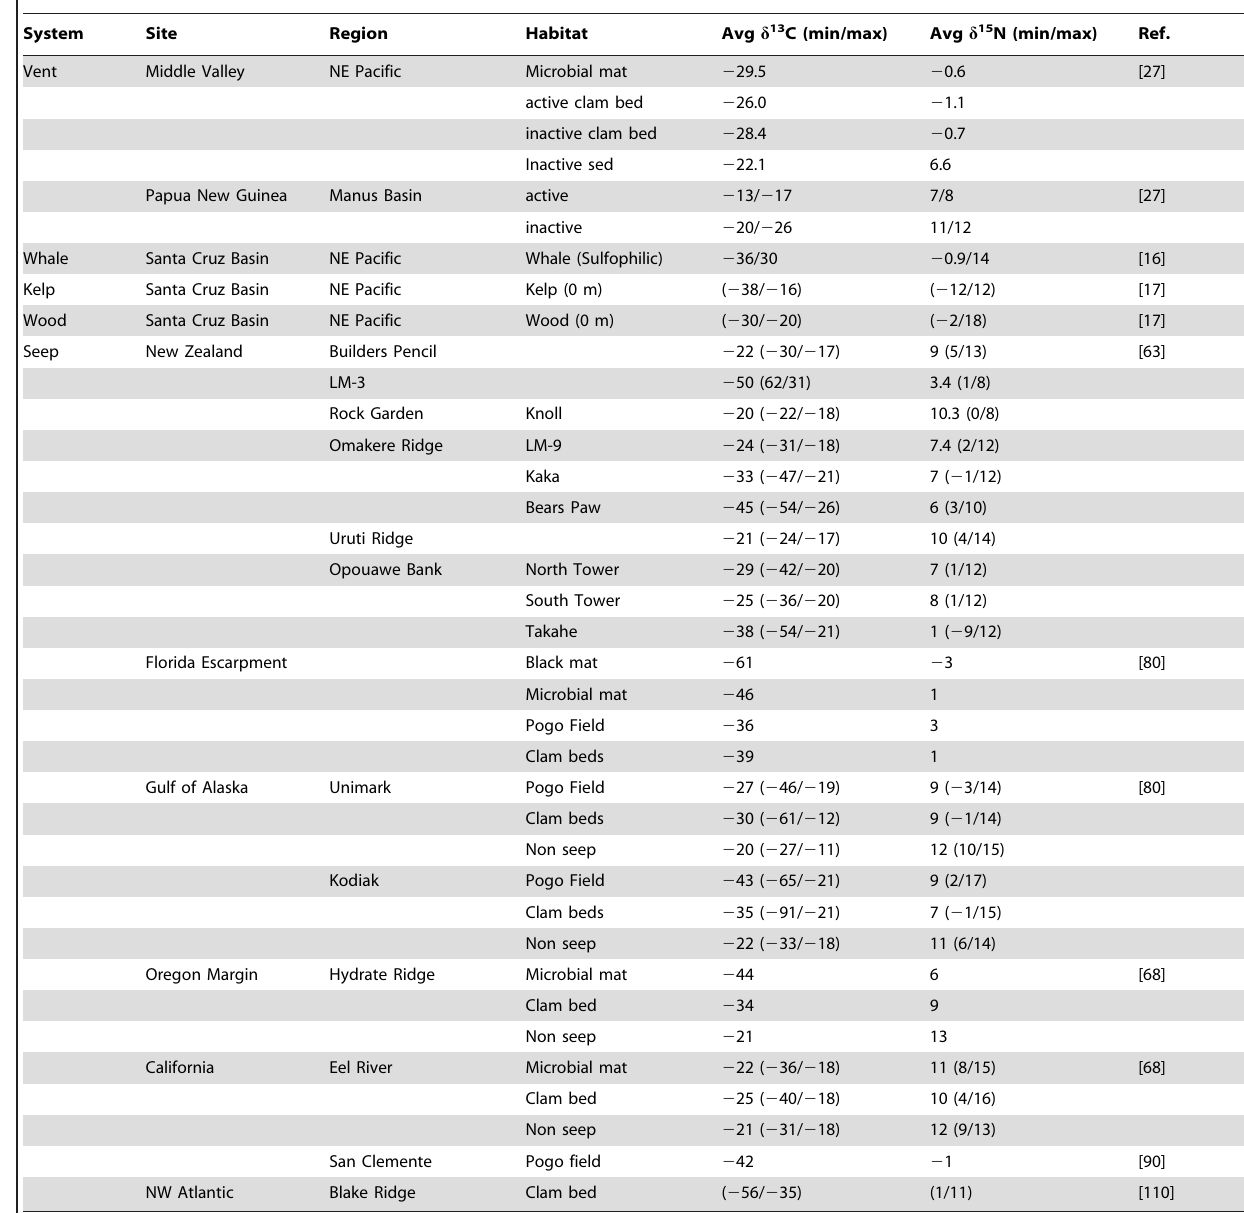
Table 3. Stable isotope signatures of sediment macrofauna from chemosynthetic sites and habitats.